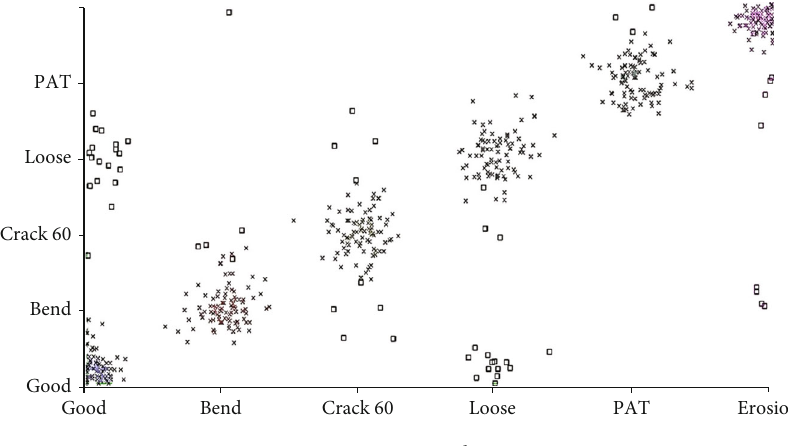
Figure 8: Errors